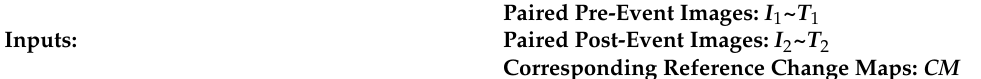
Table 1. Overview of the training process for the proposed hybrid multi-model